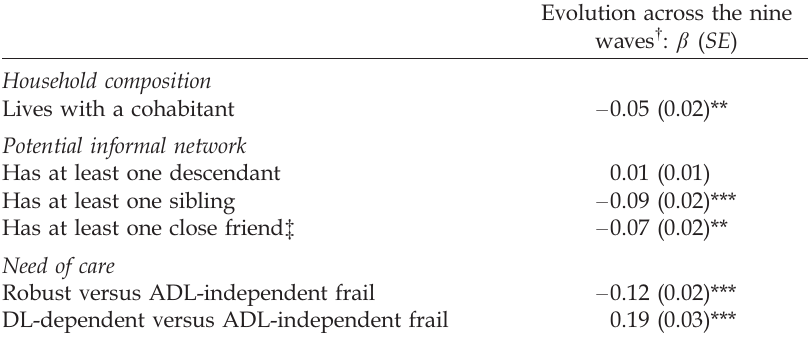
Table 3. E v olution across the nine SWILSOO wa v es ( n (cid:1) 1441 inter v